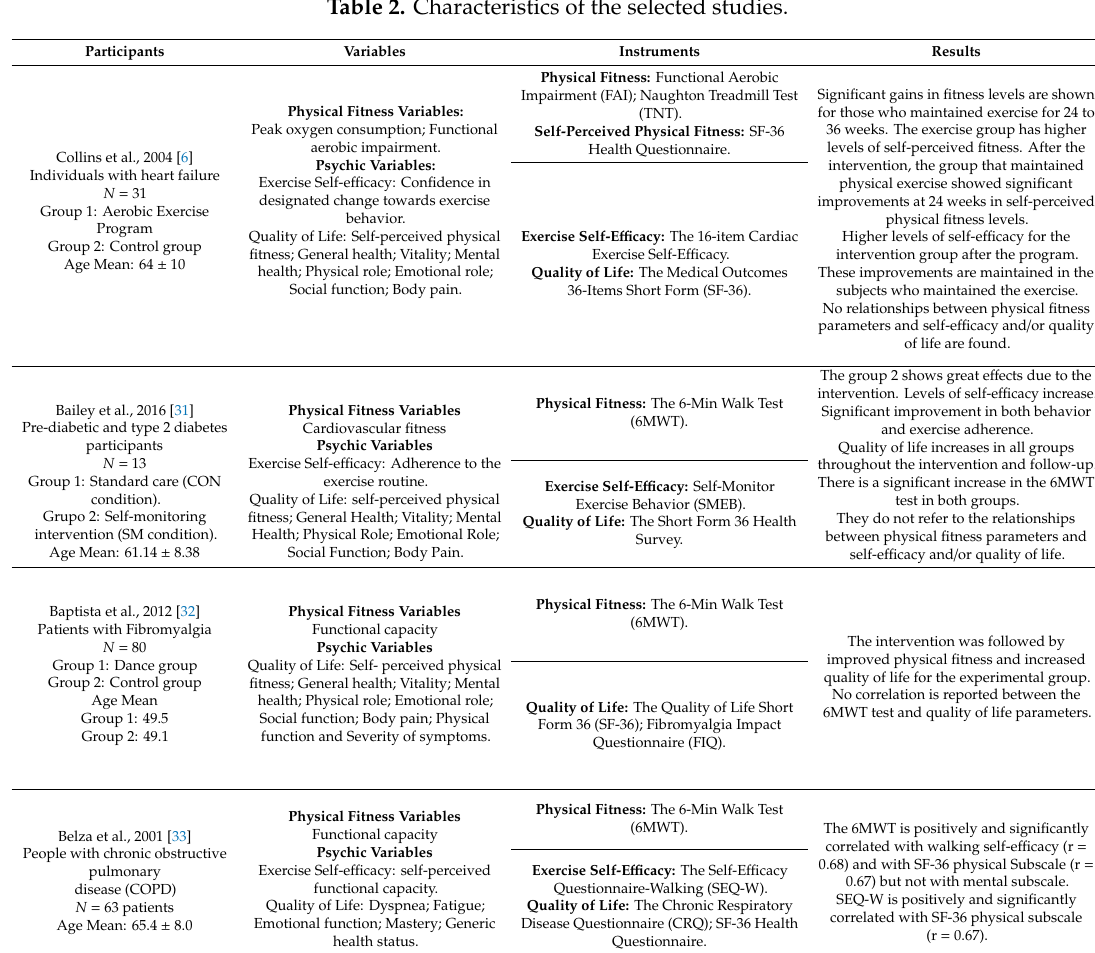
Figure 1. Flow diagram of article selection for the systematic review. Table 2. Characteristics of the selected